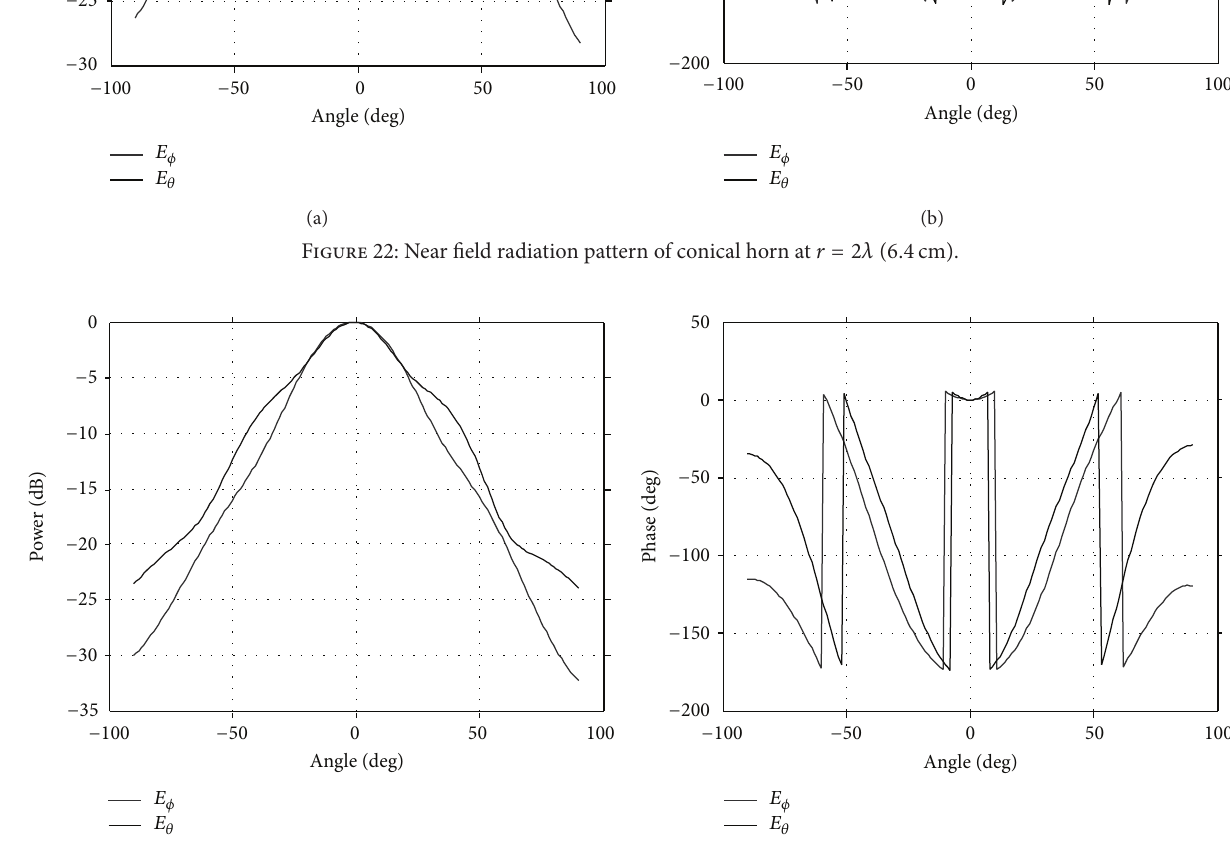
Figure 23: (a) Near field radiation pattern of conical horn at a distance 𝑟 = 3𝜆 (9.6 cm). (b) Near field phase pattern of conical horn at a distance 𝑟 = 3𝜆 (9.6